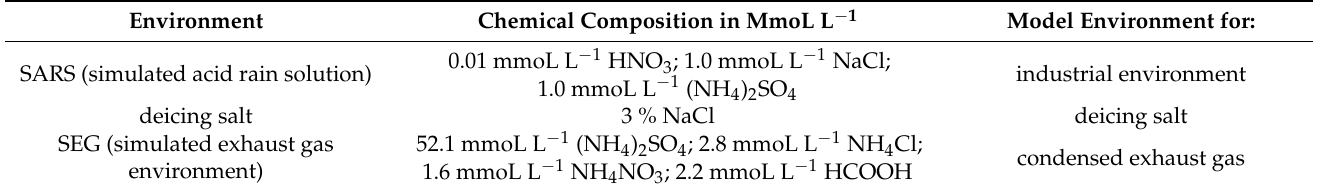
Table 2. Model environment for testing material